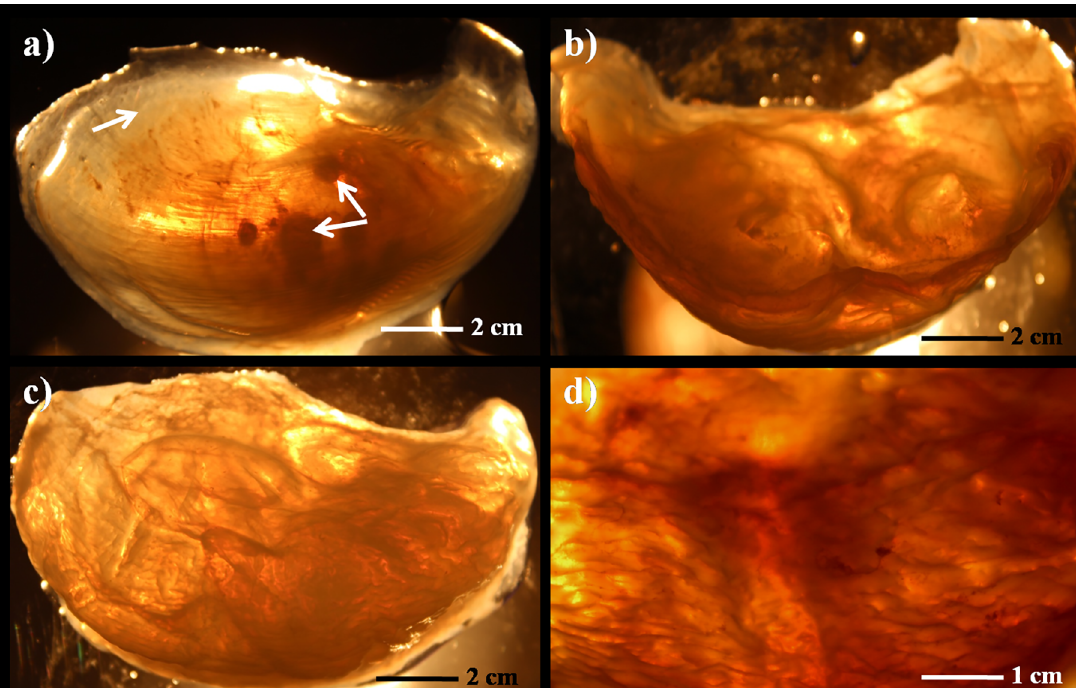
Figure 2. Optical images of a bacterial cellulose cocoon showing the internal structure of cellulose fibers inside the hydrogel: a) Granular cocoon; b)-d) Pseudo-homogeneous